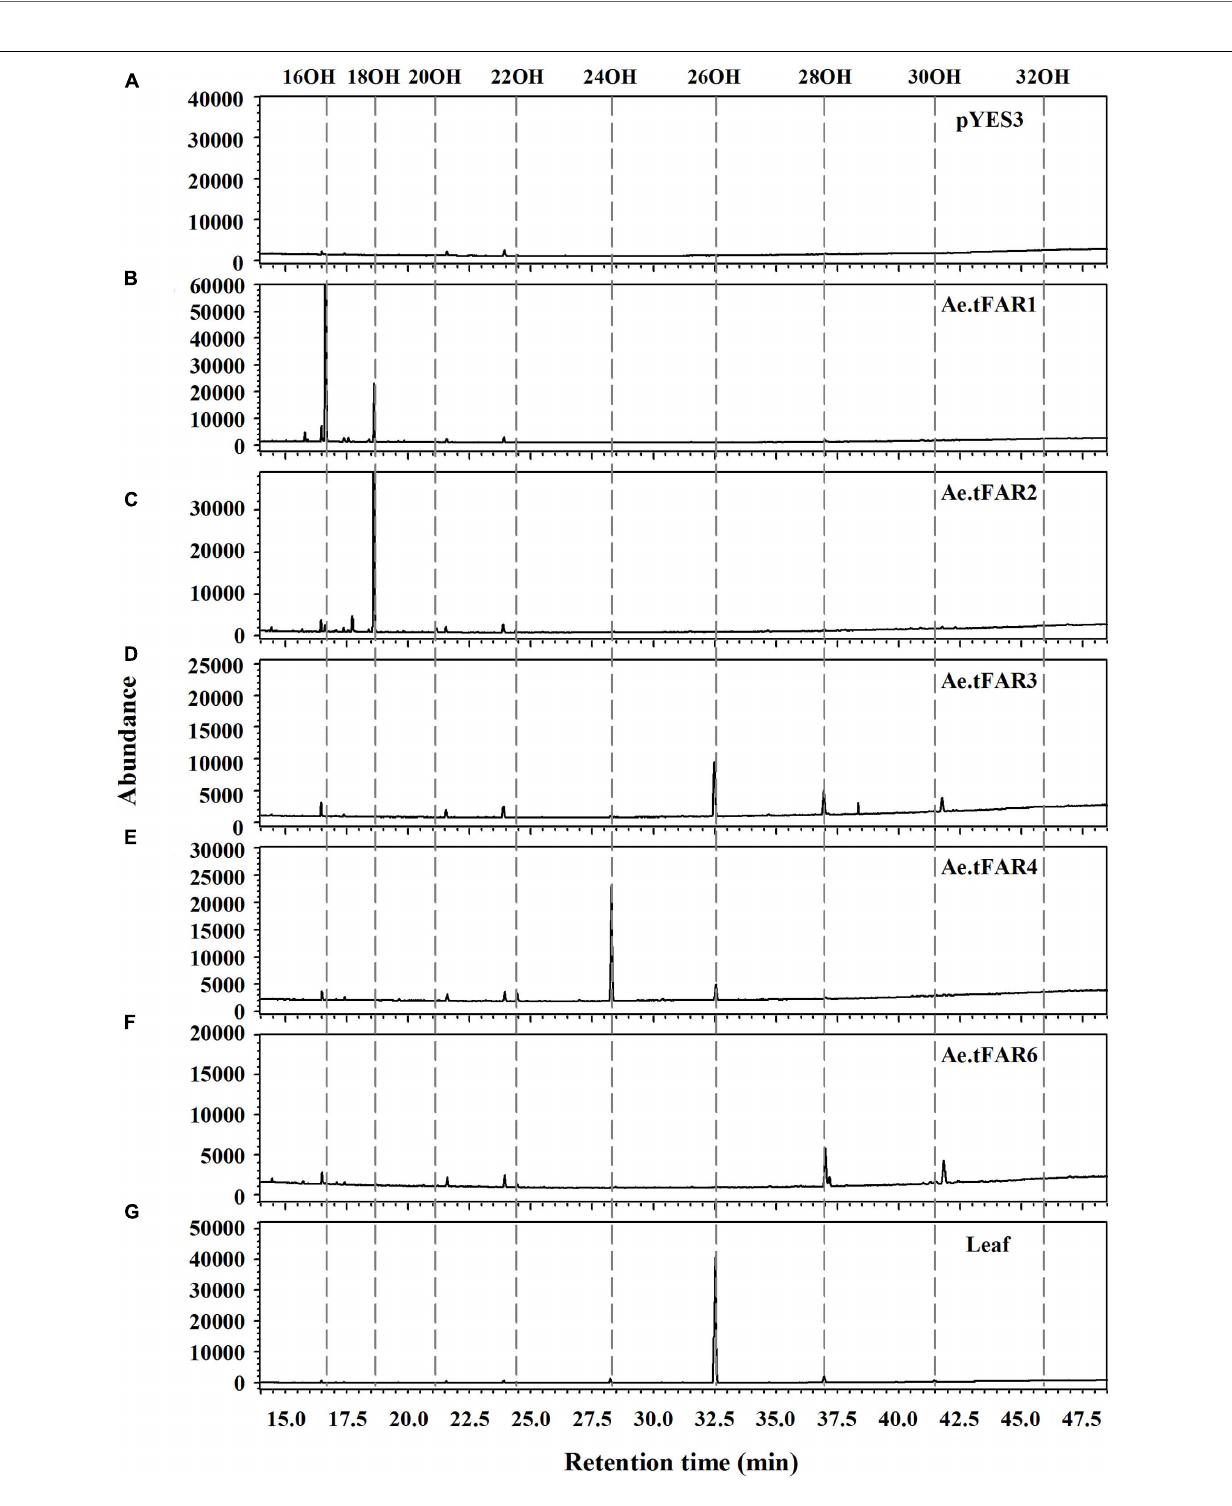
Frontiers in Plant Science |